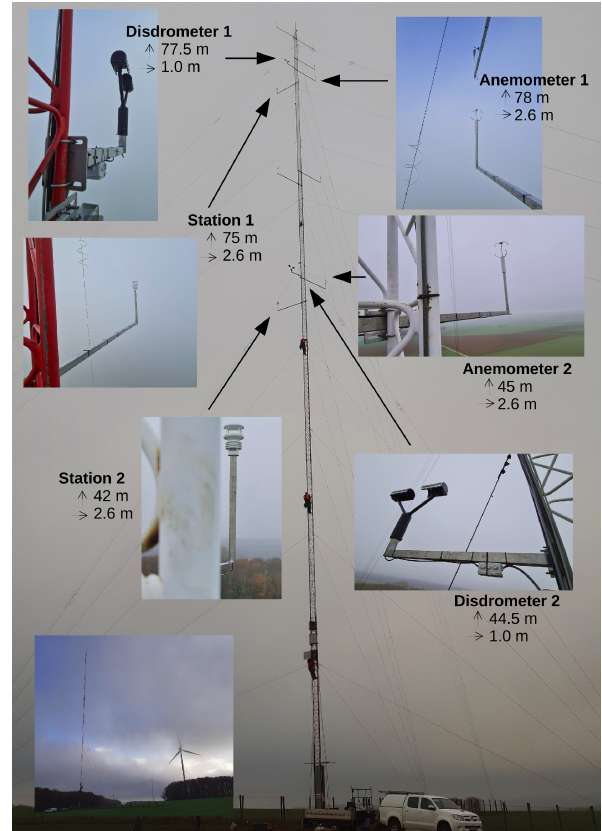
Figure 5. Summary of the measurement device’s location on the meteorological